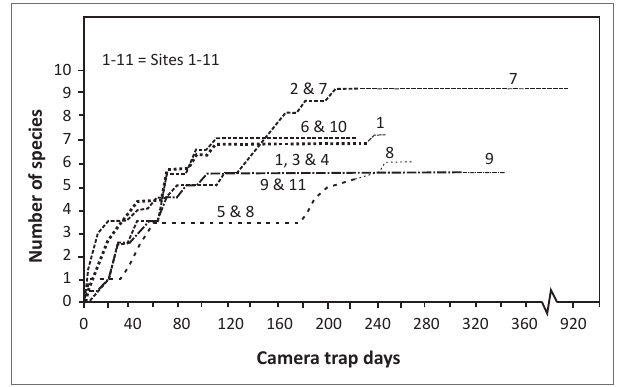
FIGURE 2: Cumulative numbers of species detected with increasing sampling effort at each forest site, with broad lines representing combined values from two or more sites and thin lines representing a single